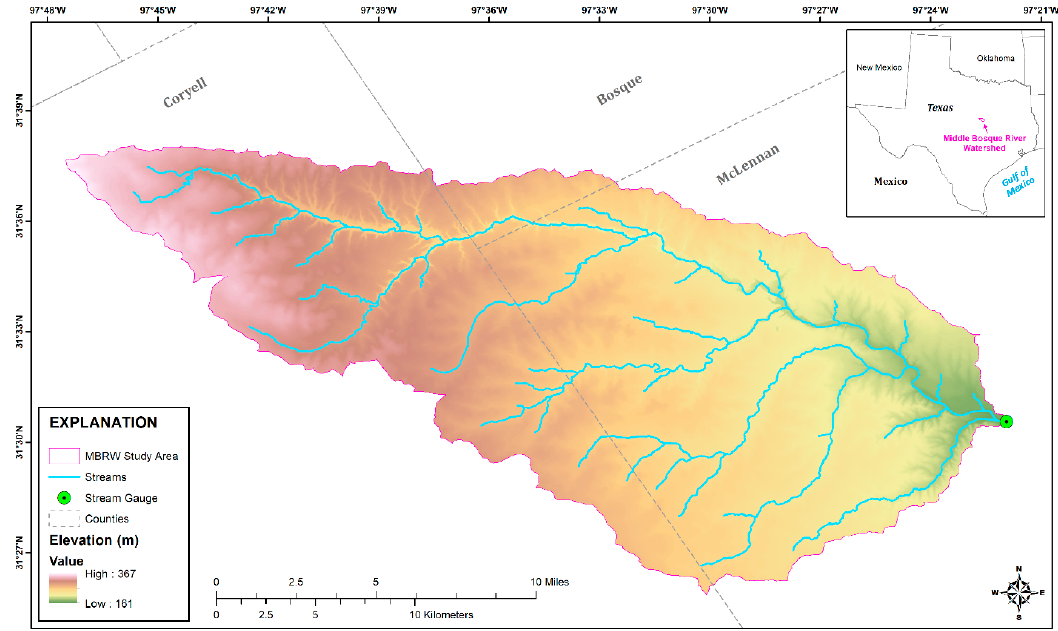
Figure 5. Location of Middle Bosque River Watershed, located in the Texas-Gulf Region of Central Texas .